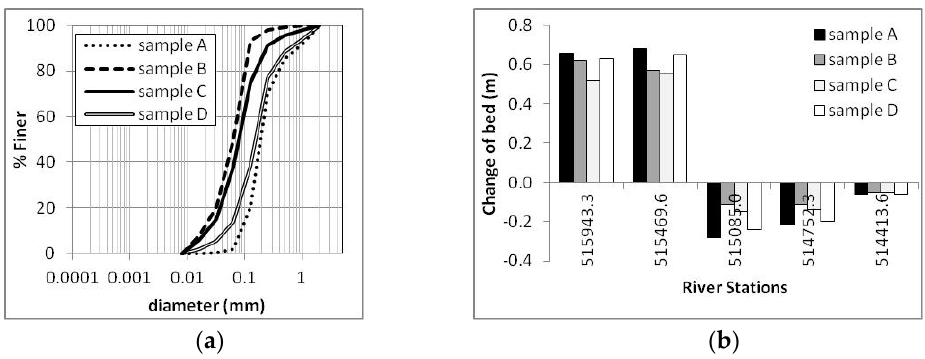
Figure 9. Sediment simulations: ( a ) Sieve curves of tested samples, ( b ) bed changes in selected River Stations.